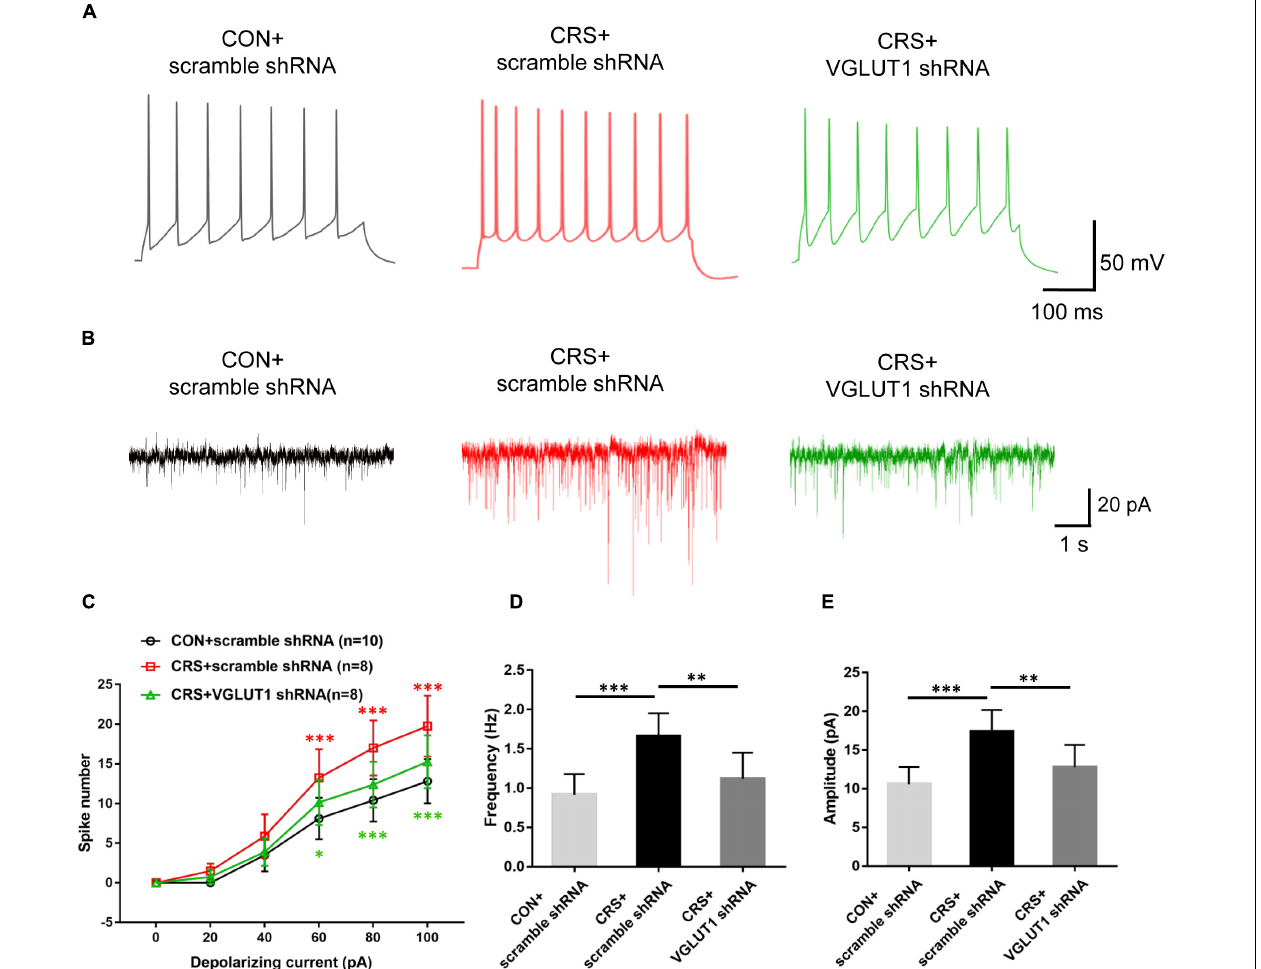
FIGURE 7 | Effects of VGLUT1 shRNA vector injections on the action potential (AP) firing frequency and sEPSCs in Vme neurons in the CON + scramble shRNA, CRS + scramble shRNA and CRS + VGLUT1 shRNA groups. (A) Representative traces evoked by intracellular injection of 80-pA depolarizing currents on Vme neurons. (B) Representative traces of sEPSCs in Vme neurons. (C) The spike number was significantly increased in the CRS + scramble shRNA group compared to the CON + scramble shRNA group when currents of 60, 80, and 100 pA were applied. The shRNA injection group produced a significantly lower number of spikes in response to currents of 60, 80, and 100 pA compared with the CRS + scramble shRNA group. (D,E) Data analyses illustrated that the frequency and amplitude of sEPSCs in CRS + scramble shRNA mice were significantly higher than those in CON + scramble shRNA mice. The frequency and amplitude were significantly